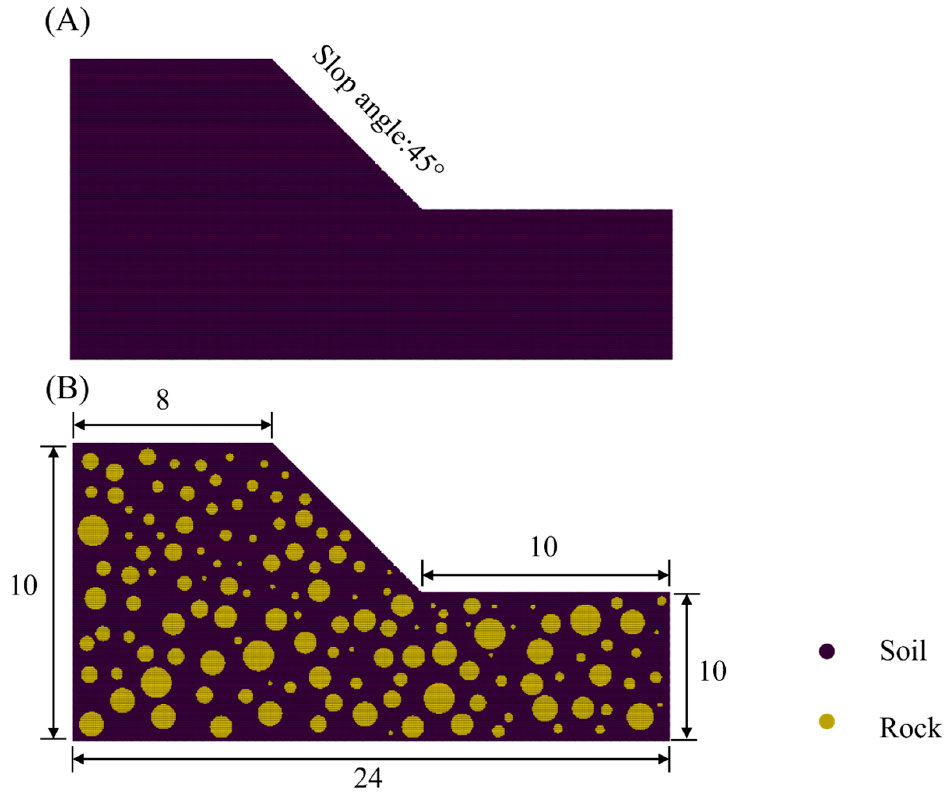
Figure 3. ( A ) Geometric parameters of pure soil slope model; ( B ) Geometric parameters of SRM slope model. (84,052 material points in total, 64,975 MPs for soil, 19,077 MPs for stone).